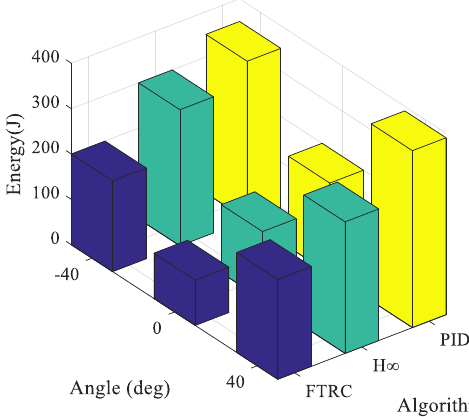
Figure 14. Bar graphic visualization of the energy consumption performance under Case 1.